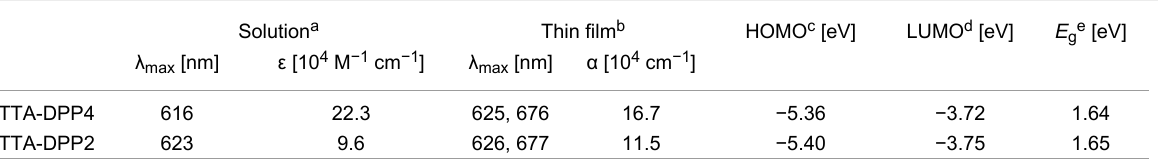
Table 1: Photophysical data of TTA-based molecules.